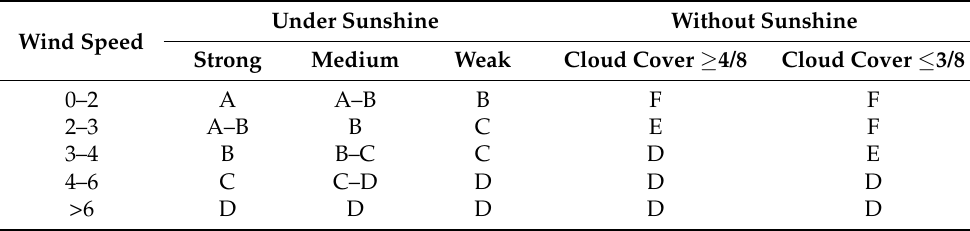
Table 4. Atmospheric stability classification.